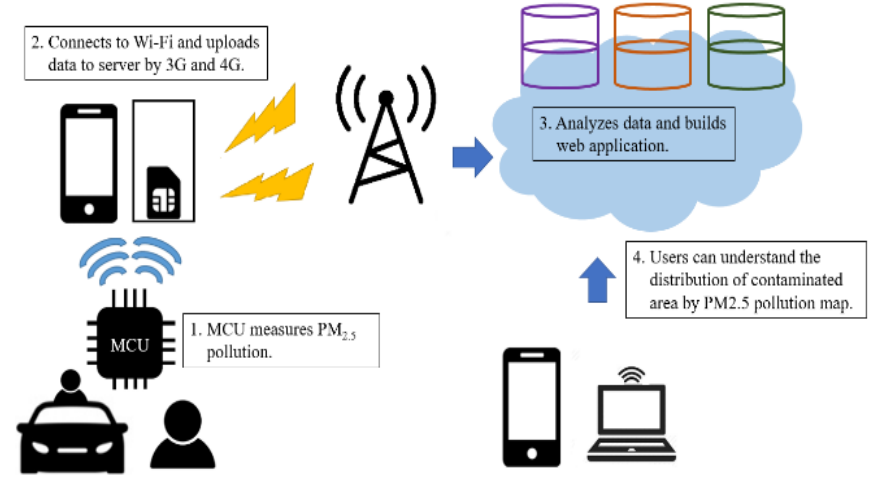
Figure 1. System architecture.